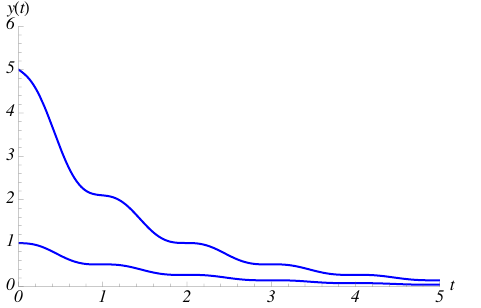
Figure 6. The deterministic curves y ( t ) , given in (38), with t 0 = 0, β = 0.6, ν ( t ) = ln [ e + 0.3 sin ( 2 π t )] and for x 0 = 1 and x 0 =